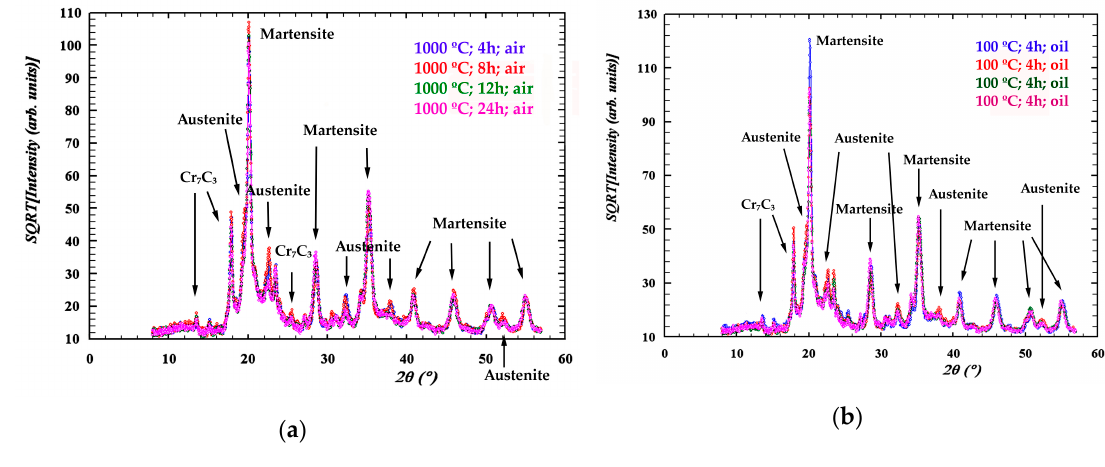
Figure 4. ( a ) Diffractograms for the air-quenched samples; ( b ) diffractograms for the oil-quenched samples.